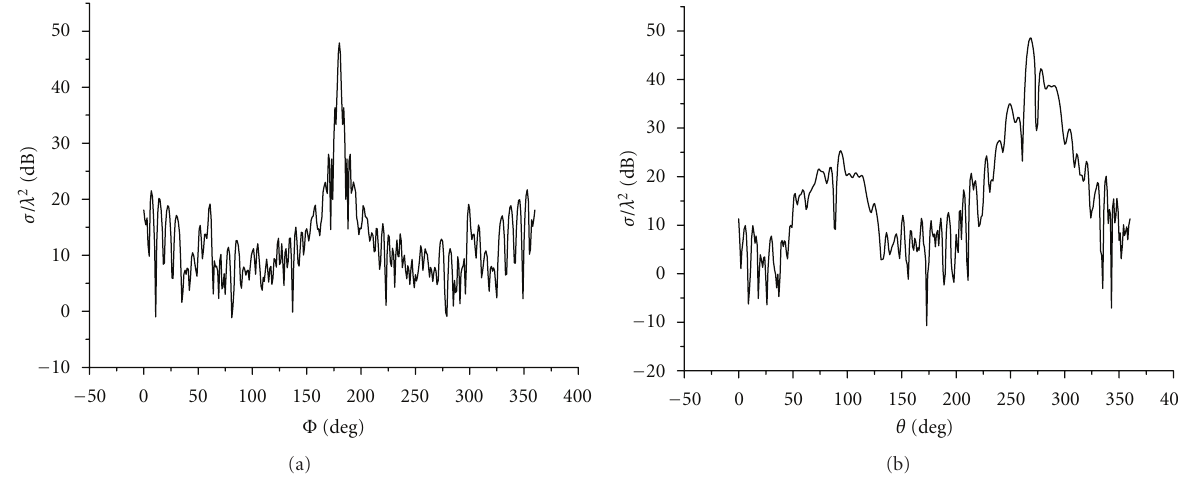
Figure 8: RCS of the airplane. (a) E-plane ( x o y ). (b) H-plane ( x o z ).